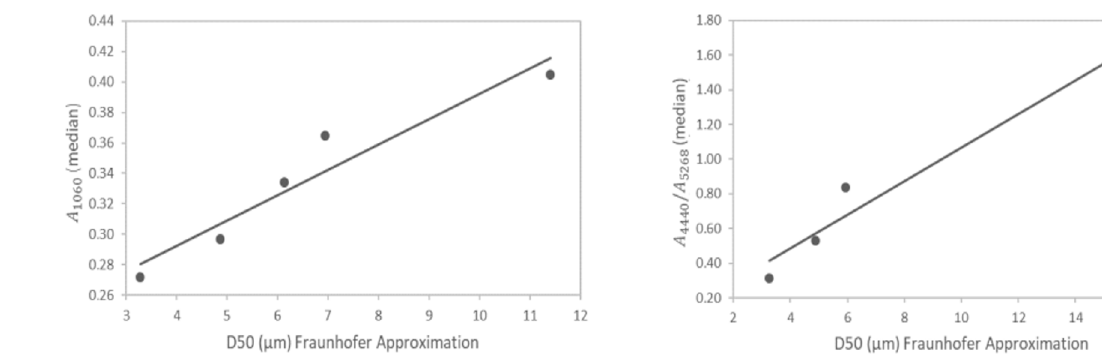
Figure 3. DRIFT/MIR calibration curve (A silica D50 samples particle diameter calculation by Fraunhofer Approximation.